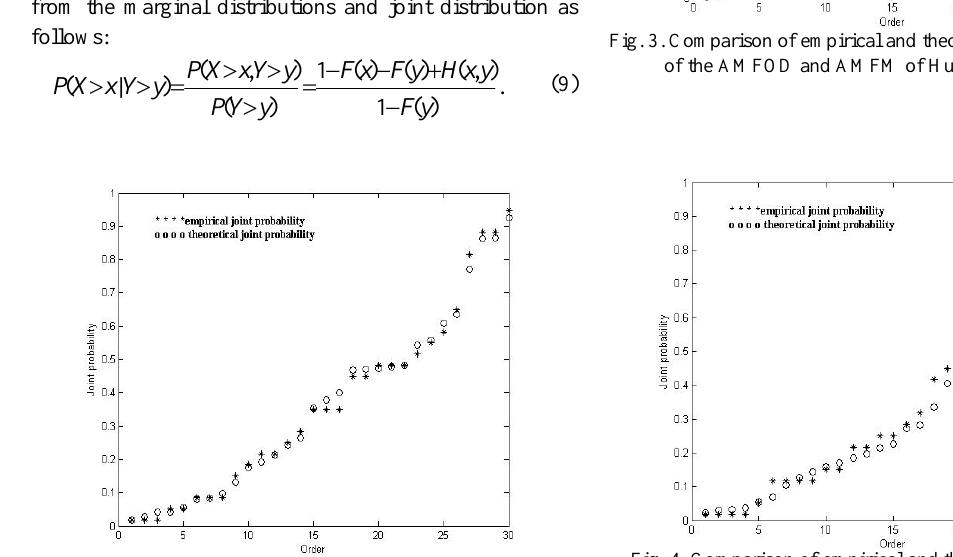
Fig. 4. Comparison of empirical and theoretical joint probability of the AMFODs of Sanmenxia and Huayuankou stations